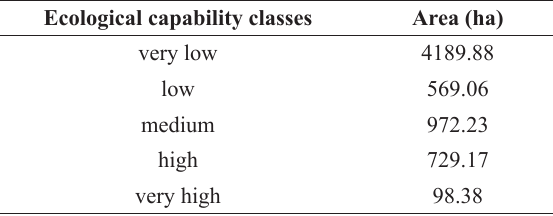
Area of overlay classes using AND operator.